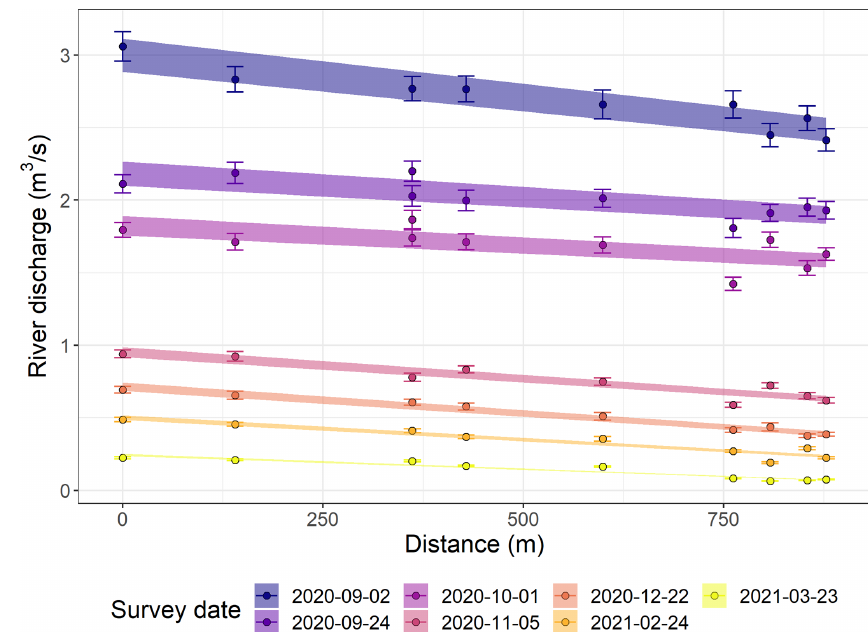
Figure 5. Differential flow gauging measurements and linear model ensembles used to calculate the transmission losses.